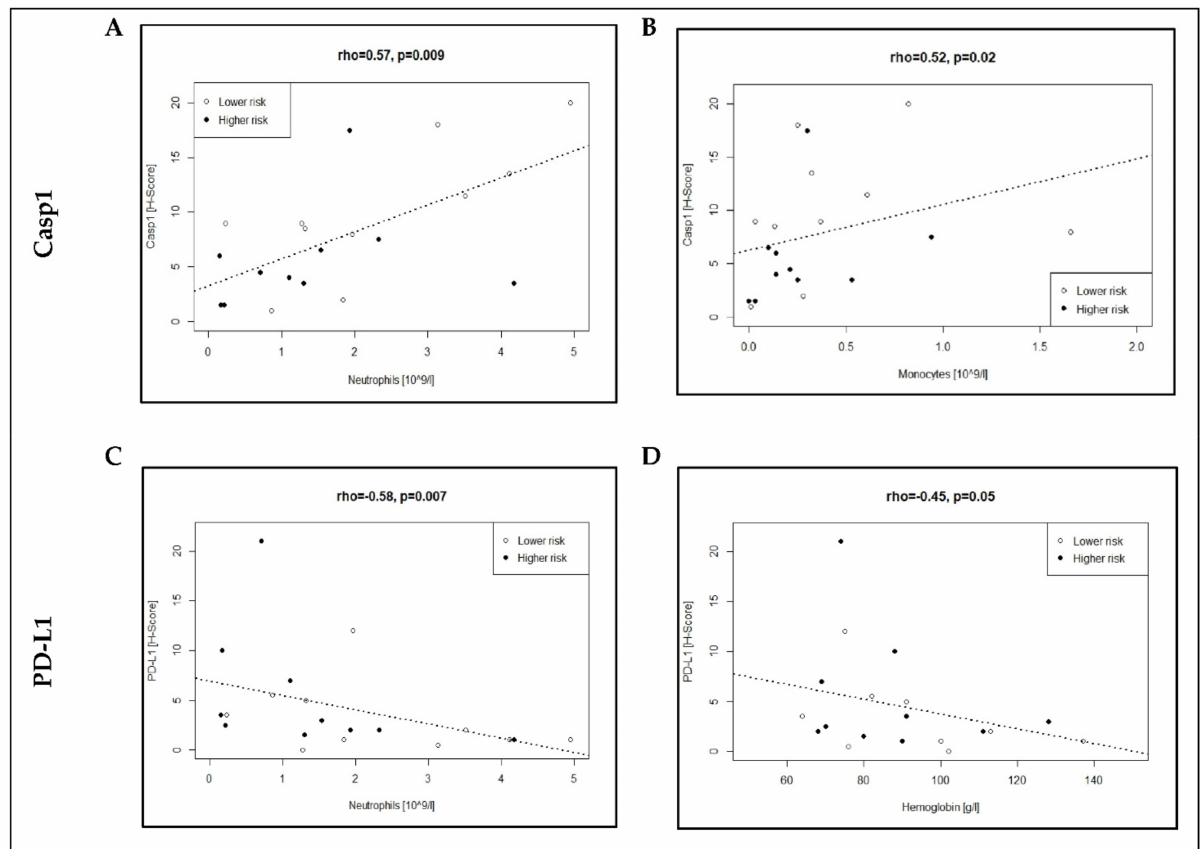
Figure 3. Relevant correlations between immune-related biomarkers Casp1 ( A , B ) and PD_L1 ( C , D ) and blood counts in MDS patients. Regression analysis was performed with Spearman’s rank correlation and significance determined using Bonferroni correction. Refer also to Table